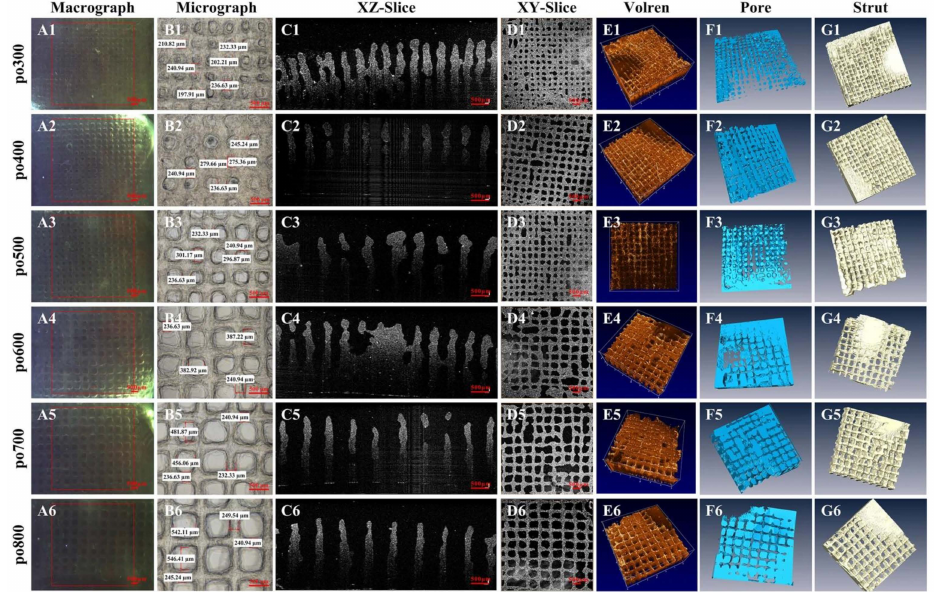
Figure 10. Cell-laden 3D bioprinted structures with varying pore size characterized using OCT ( A1 – A6 ) Macrographs ( B1 – B6 ) Micrographs, ( C1 – C6 ) C OCT Cross-sectional images to a depth of 3 mm. ( D1 – D6 ) en-face OCT images. ( E1 – E6 ) rendering in 3D and ( F1 – F6 , G1 – G6 ) 3D reconstruction of hydrogel exhibiting variation in pore size. Image reprinted with permission from [132] under the creative commons license CC BY 4.0. Copyright © 2023 by the authors; Scientific Reports